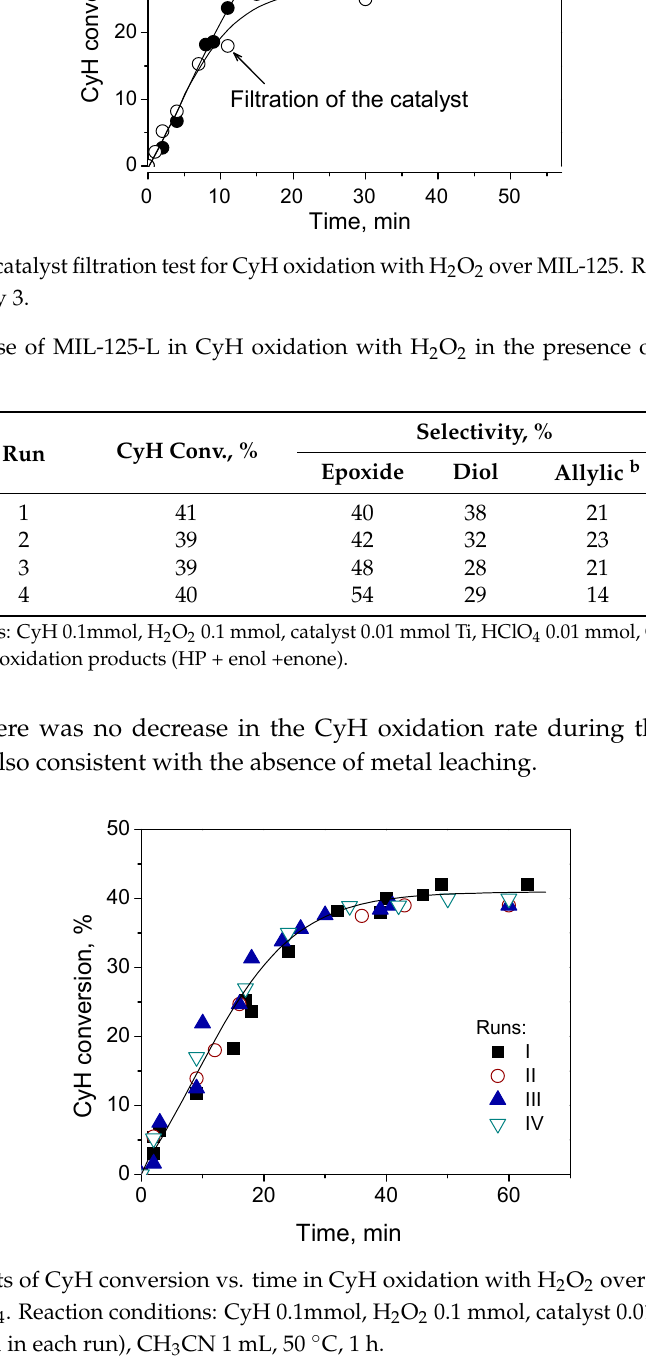
Figure 8. The plots of CyH conversion vs. time in CyH oxidation with H 2 O 2 over MIL-125-L in the presence of HClO 4 . Reaction conditions: CyH 0.1mmol, H 2 O 2 0.1 mmol, catalyst 0.01 mmol Ti, HClO 4 0.01 mmol (added in each run), CH 3 CN 1 mL, 50 o C, 1 h.